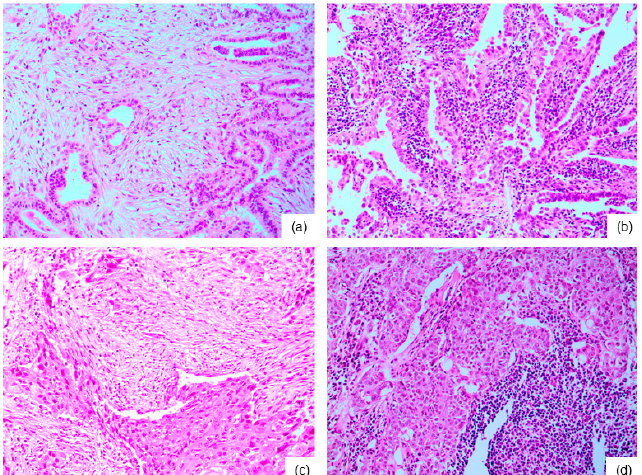
Figure 1. Tumor stroma in thyroid cancer. Papillary thyroid carcinoma (PTC) shows desmoplastic tumor stroma mainly composed of caner-associated fibroblasts (CAF) (×100) ( a ). Prominent immune cells are noted in PTC subtype such as Warthin-like variant (×100) ( b ). Fibrous stroma composed of CAF is noted in anaplastic thyroid carcinoma (×100) ( c ). Immune cells stroma is present in poorly differentiated thyroid carcinoma (×100) ( d